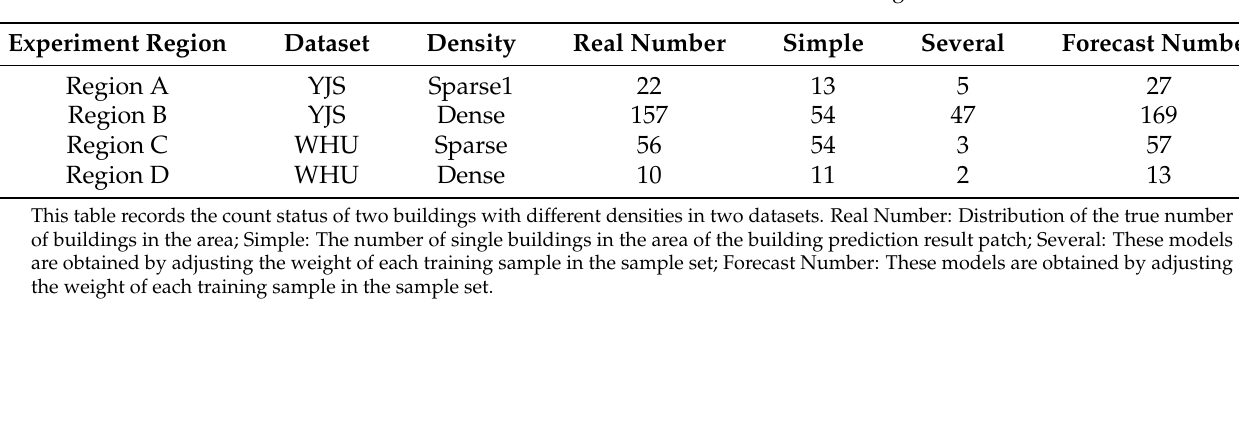
Figure 15. The building counting analysis of four regions, where A is the relatively sparse area of buildings in the Yaji Mountain region, B is the relatively dense area of buildings in the Yaji Mountain region, C is the relatively sparse area of buildings in the WHU dataset, and D is the relatively dense area of buildings in the WHU dataset. Table 9. The results of model classification under different training